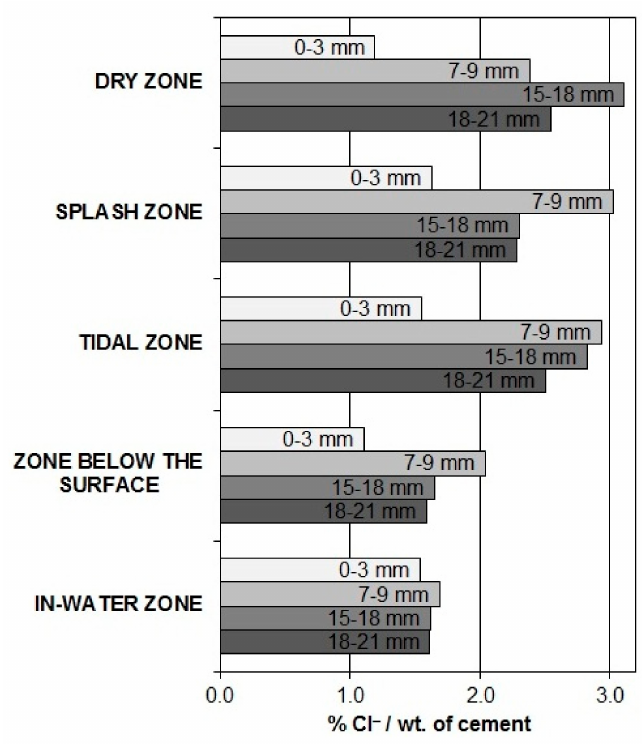
Figure 8. Total Cl - content in all the exposure zones at four di ff erent concrete